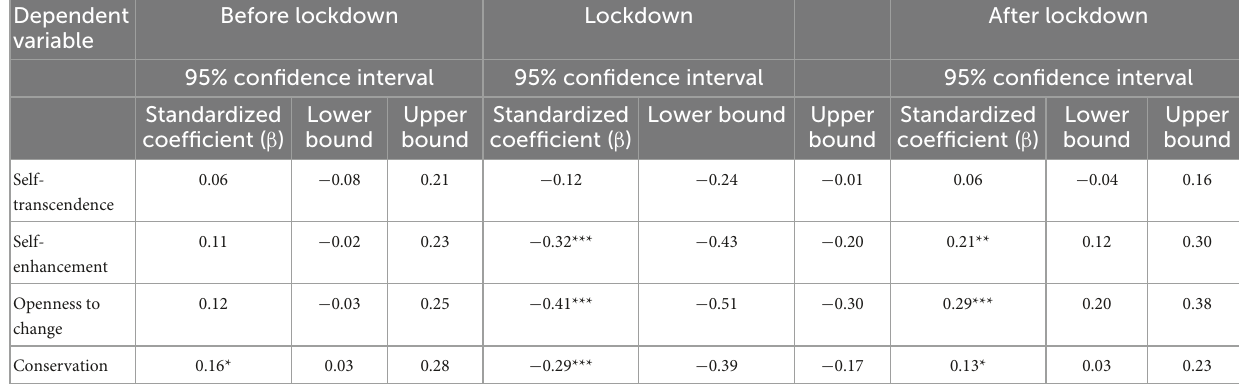
TABLE 4 Correlations between circumstances before the lockdown, during the lockdown, and after the lockdown and individual level higher-order dimensions of personal values a .